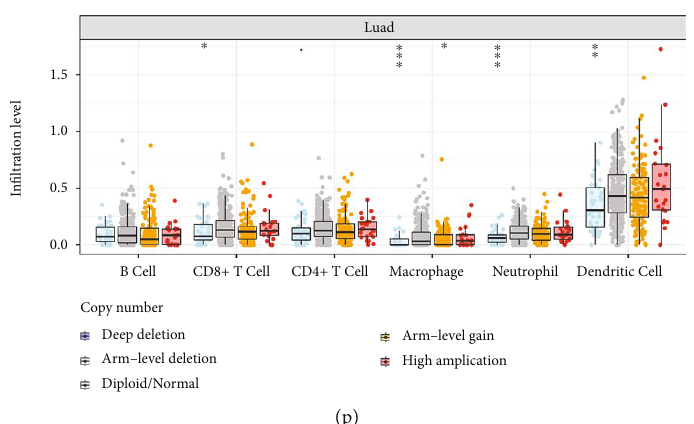
Figure 5: Eight genes and immune cell in fi ltration. (a and b) ADRB2. (c and d) AGER. (e and f) CDKN3. (g and h) GJB2. (i and j) SFTPC. (k and l) SLC2A1. (m and n) SLC6A4. (o and p)